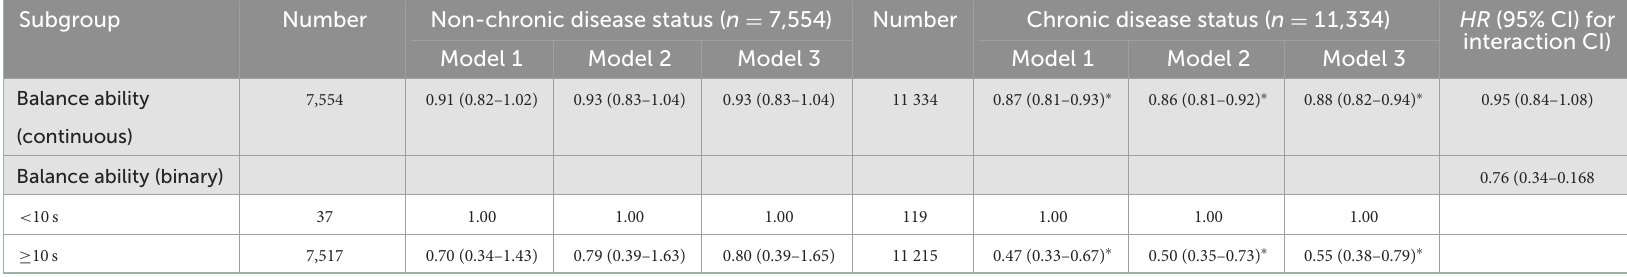
TABLE 4 Cox risk proportional model of death risk among participants with chronic disease or